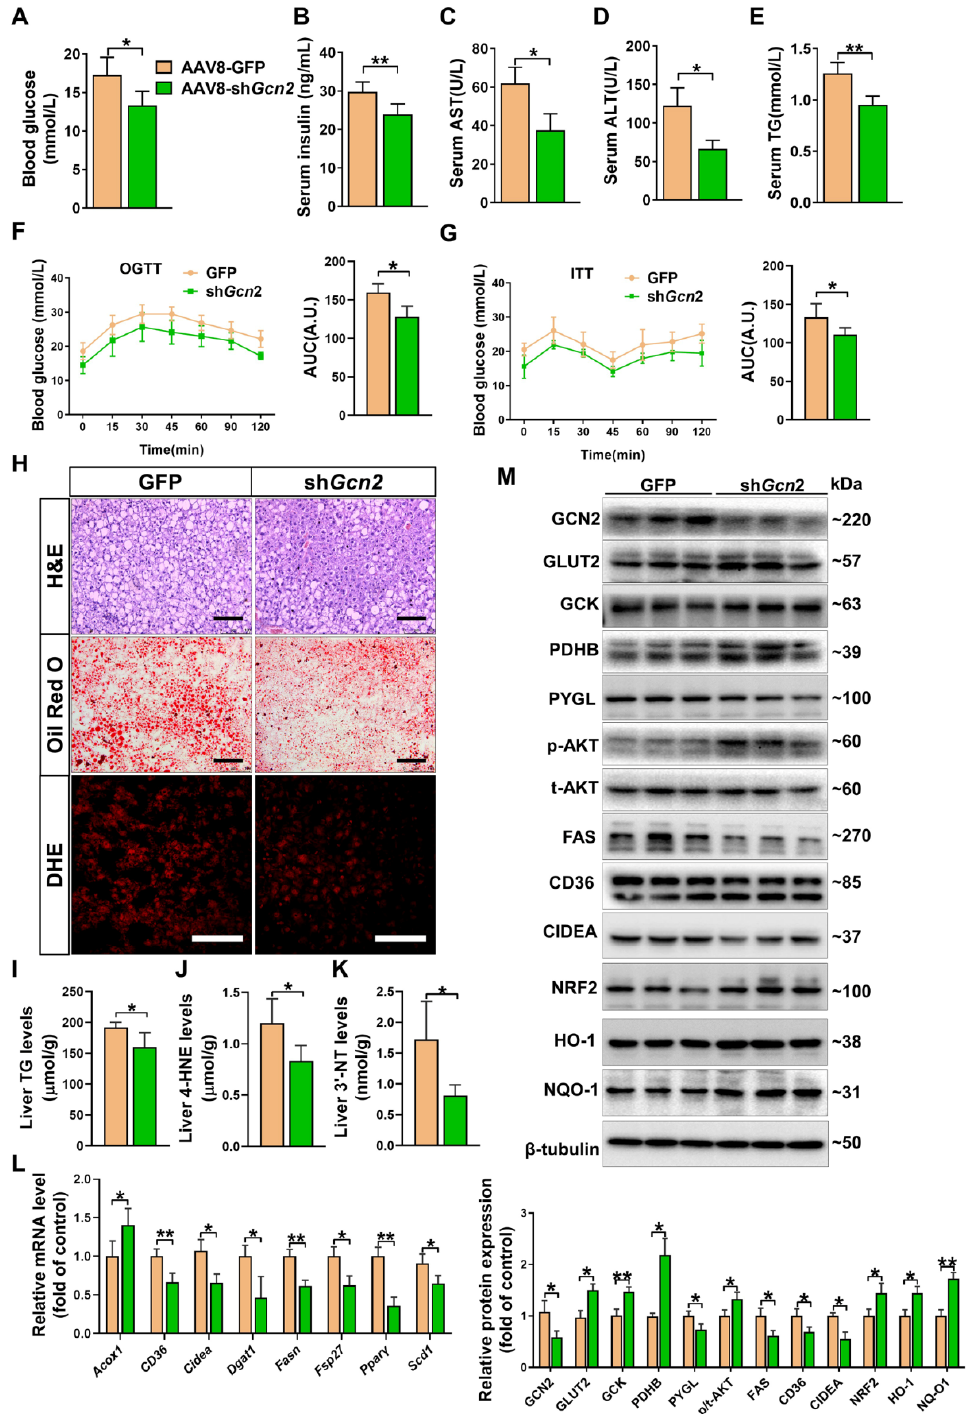
Figure 5. GCN2 knockdown ameliorates metabolic disorders in db/db mice. Db/db mice were treated with AAV8-GFP or AAV8-sh Gcn2 via intravenous tail injection. After 4 weeks, the mice were sacrificed, and fasting blood glucose ( A ), serum insulin ( B ), AST ( C ), ALT ( D ), and TG ( E ) levels were measured. OGTT ( F ) and ITT ( G ) were performed on GFP- and sh Gcn2 -treated db/db mice and the corresponding AUC values in each group were calculated. ( H ) Representative liver sections were stained with H&E, oil red O, and DHE. Scale bar = 100 μ m. Liver TG) ( I ), 3 ′ -NT ( J ), and 4-HNE ( K ) levels were measured. ( L ) The mRNA levels of lipid metabolic genes were measured by qPCR. ( M ) Liver lysates were analyzed by Western blot. N = 5 ( A – L ) or 3 ( M ); values represent the mean ± SD; * indicates p < 0.05; ** indicates p <